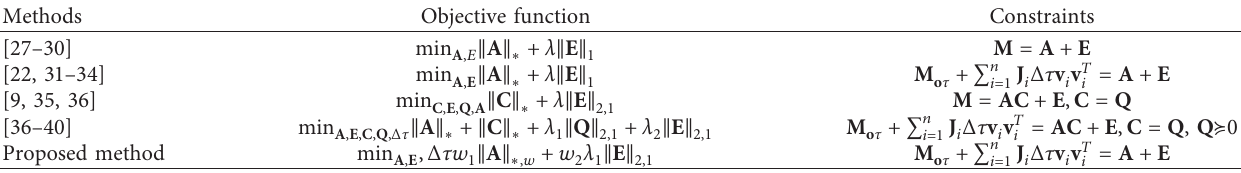
Table 1: Comparison of the proposed approach with other related algorithms in terms of the objective function and constraints.